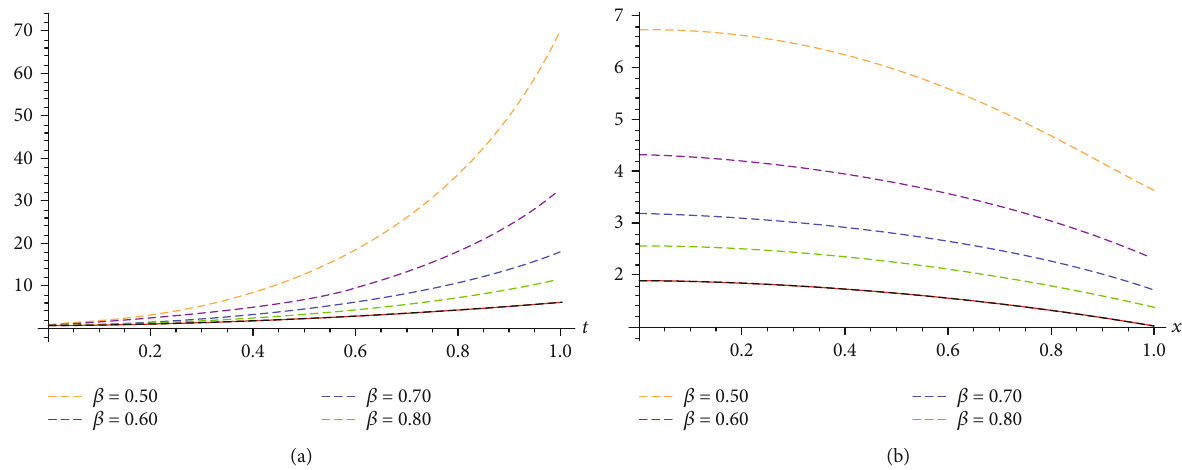
x , t Þ at fi xed value of x = π /6 ; (b) plots of exact 10 ð